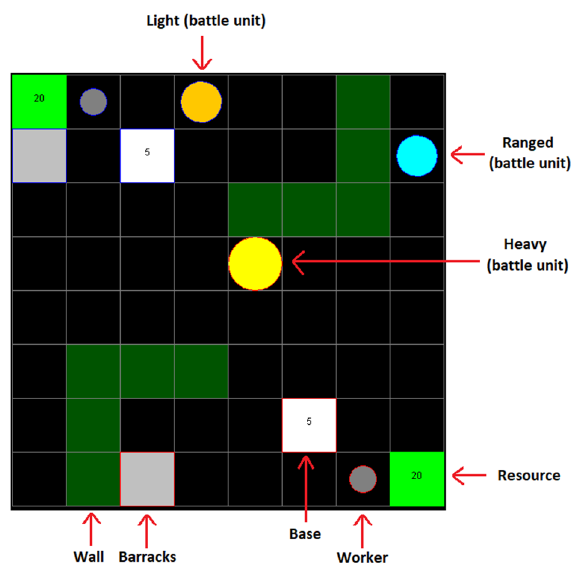
Figure 1. Micro real-time strategy (microRTS) environment, with all features visible.